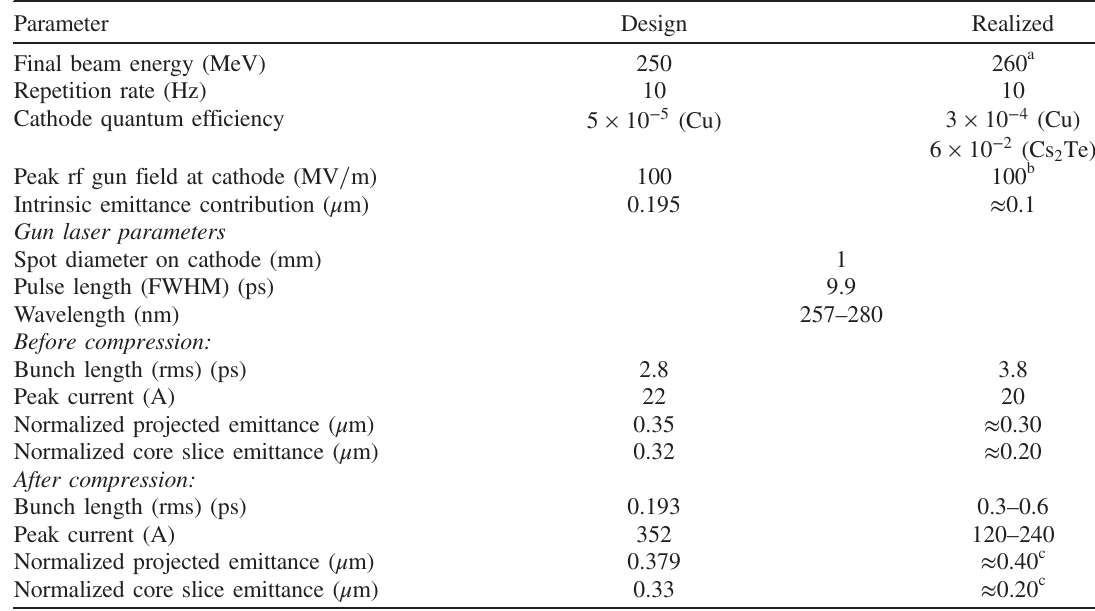
TABLE I. Main design parameters of the SwissFEL Injector Test Facility for the high-charge mode (200 pC bunch charge), with comparison to typically realized values.